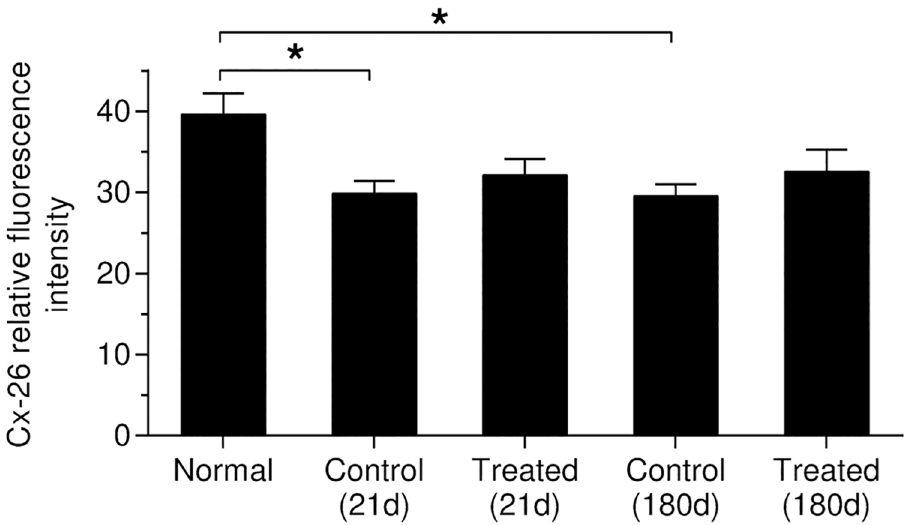
Fig 14. Connexin 26 relative fluorescence intensity in the OC was measuredand statistically analyzed. Both noise exposedtreated and control (untreated)groups showeda similar significantdecrease in Cx-26 expressionat 21 days and 6 months after noise exposurecompared to the normal (na ï ve)animals ( p < 0.05).